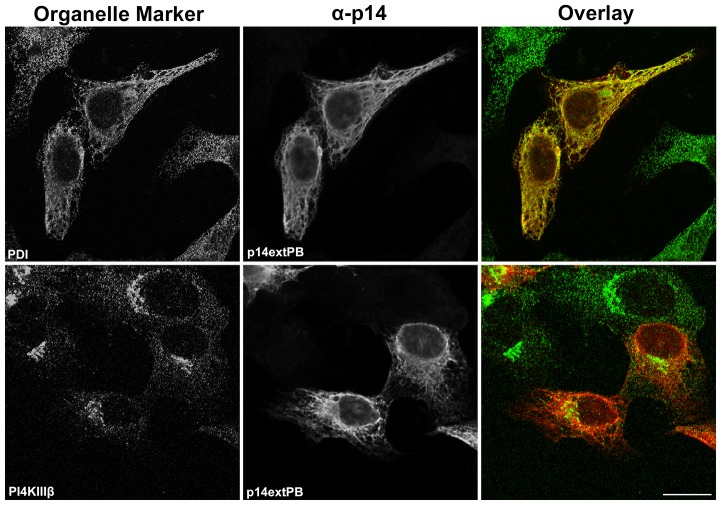
Membrane-distal PBM dominates over membrane-proximal PBM.Vero cells were transfected with p14extPBin a p14-V9T backbone and immunostained with anti-p14 antiserum (red) and the indicated organelle markers (green) as in Figure 2. Right column shows merged images. Scale Bar  =  20 μm.